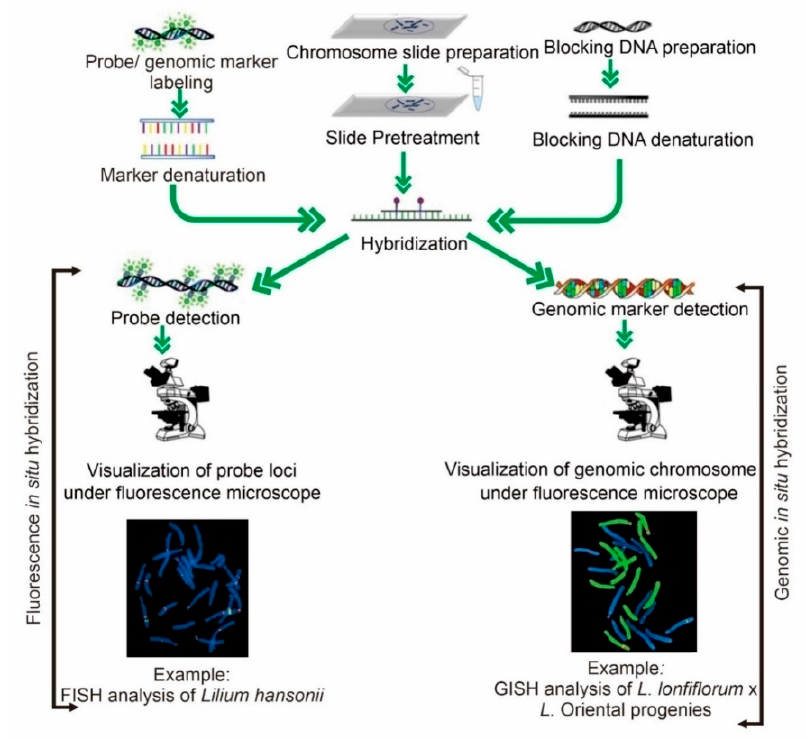
Figure 3. Working steps for fluorescent and genomic in situ hybridization were used for the cyto- genetic study of horticultural modified crops. Different methods, such as nick translation, random primed labeling, and PCR, are used to label the probe during marker labeling. Various methods, such as autoclaving, shearing the DNA with a tiny needle in a syringe, or sonicating, are used to prepare to block DNA. Chromosome slide preparation is the selection of well-spread chromosomes prepared from a young root tip using an enzyme mixture at 37 ◦ C. Slide pretreatment is the enzymatic digestion of the chromosomes in order to unmask the DNA prior to hybridization. Hybridization involves the attachment of blocking and probe/genomic markers with chromosomes to identify the specific loci/origin of the genome of the respective chromosome. During detection, attachment of the designed antibody against the target marker along with blocking buffer to detect the specific fluorochrome.